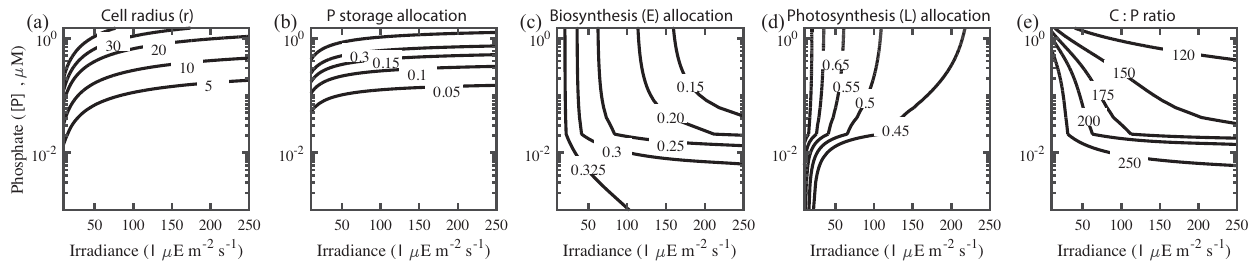
Figure 5. Influence of phosphate concentration and irradiance on cellular stoichiometry and cellular traits, at a constant T = 25 ◦ C. (a) Cell radius ( r ). (b) P storage allocation. (c) Biosynthesis allocation. (d) Photosynthesis ( L ) allocation. (e) The C : P ratio. As irradiance increases, there is a tendency towards greater allocation to biosynthesis and lesser allocation to photosynthesis, which leads to lower C : P ratios. When phosphorus is very low, there is a large decrease in both biosynthesis and photosynthesis allocations due to the large relative allocation to the cell membrane. C : P ratios are inversely proportional to phosphorus concentration, driven by an increase in luxury storage and ribosomal content as P